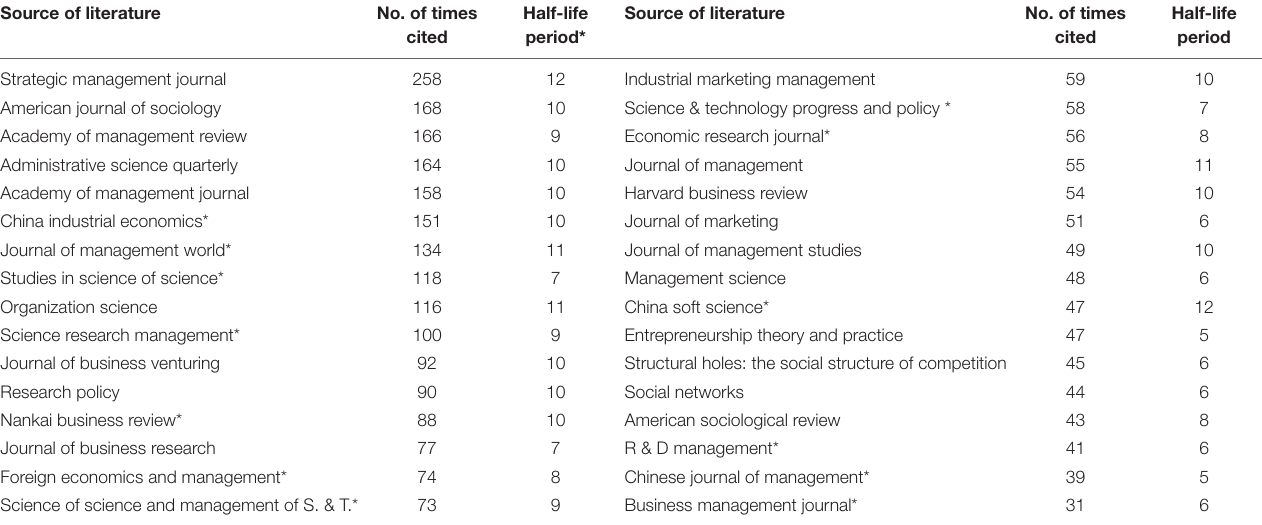
TABLE 5 | List of sources with high frequency of co-citation.